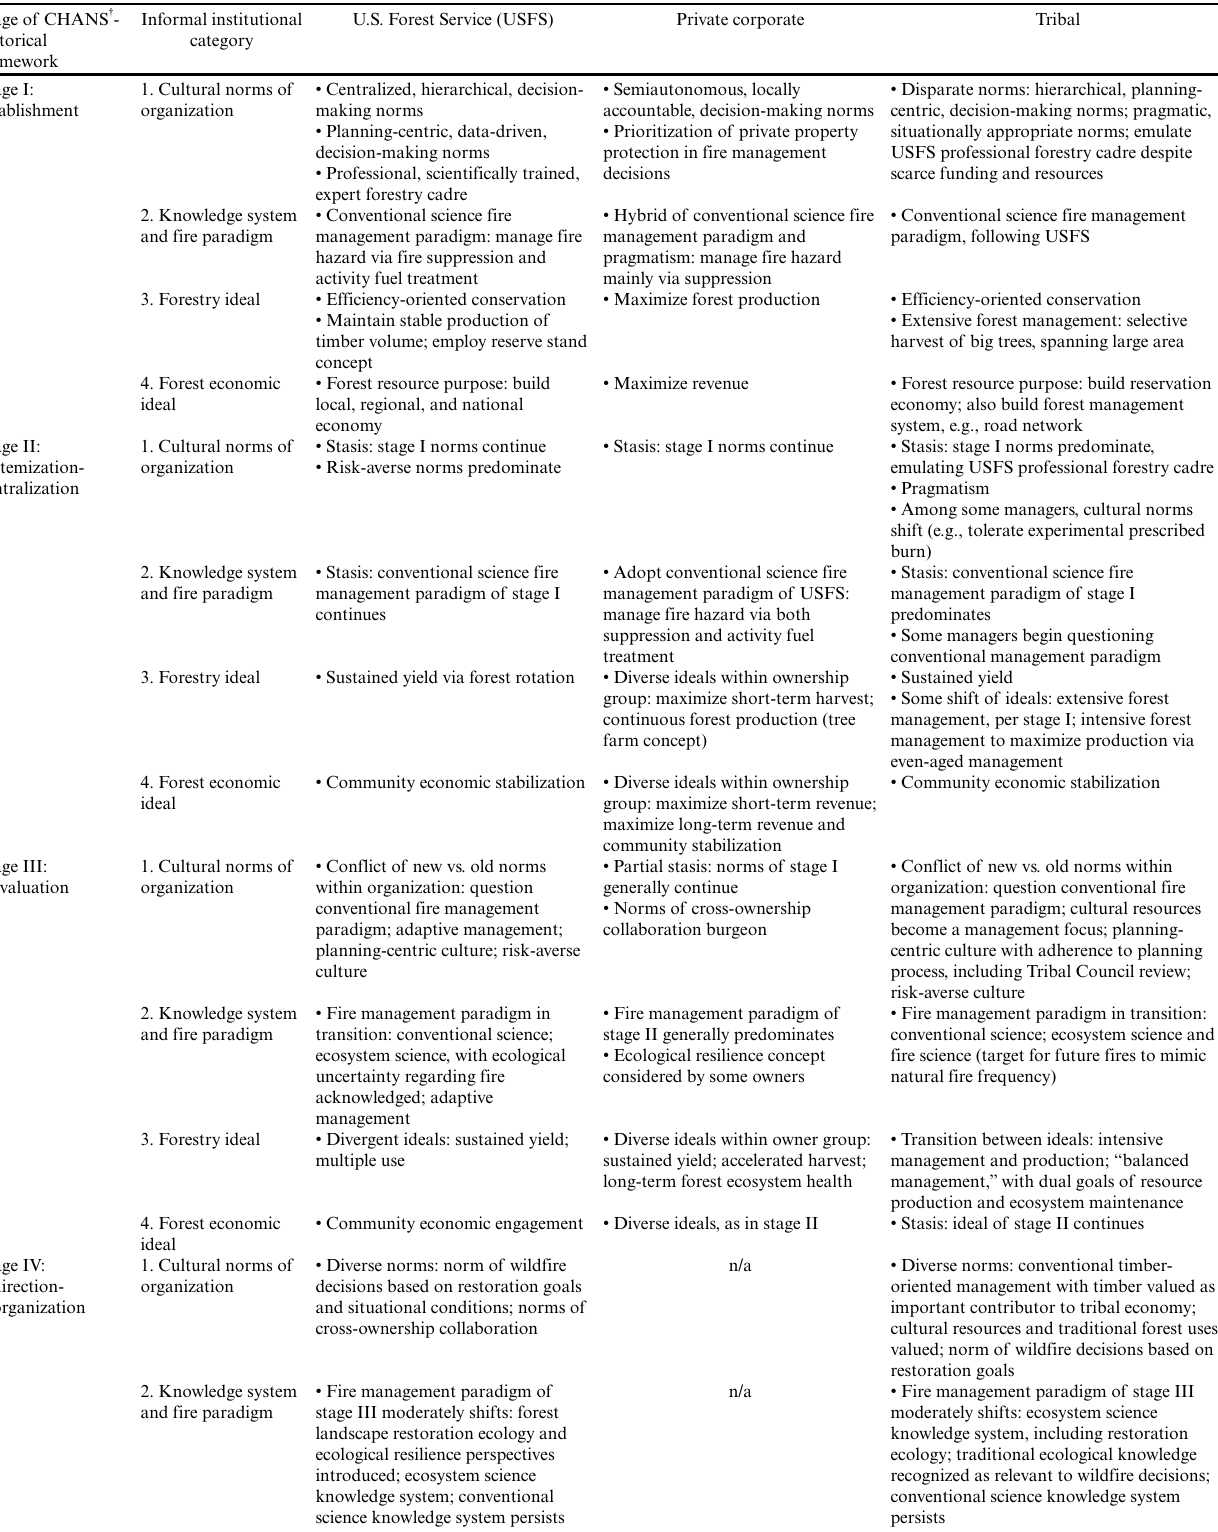
Table 6. Evolution of wildfire informal institutions among U.S. Forest Service, private corporate, and tribal ownership groups. Stage of CHANS † - historical